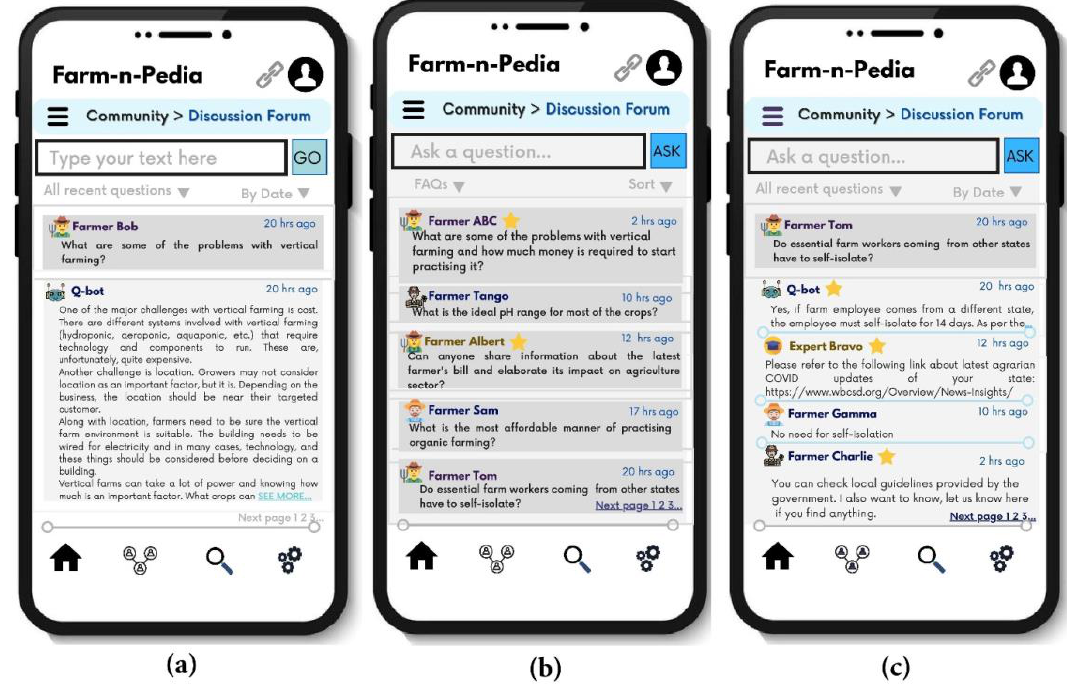
Figure 2 Mobile app screenshots depicting expert KBS (offline) and social media mode (online) in the discussion